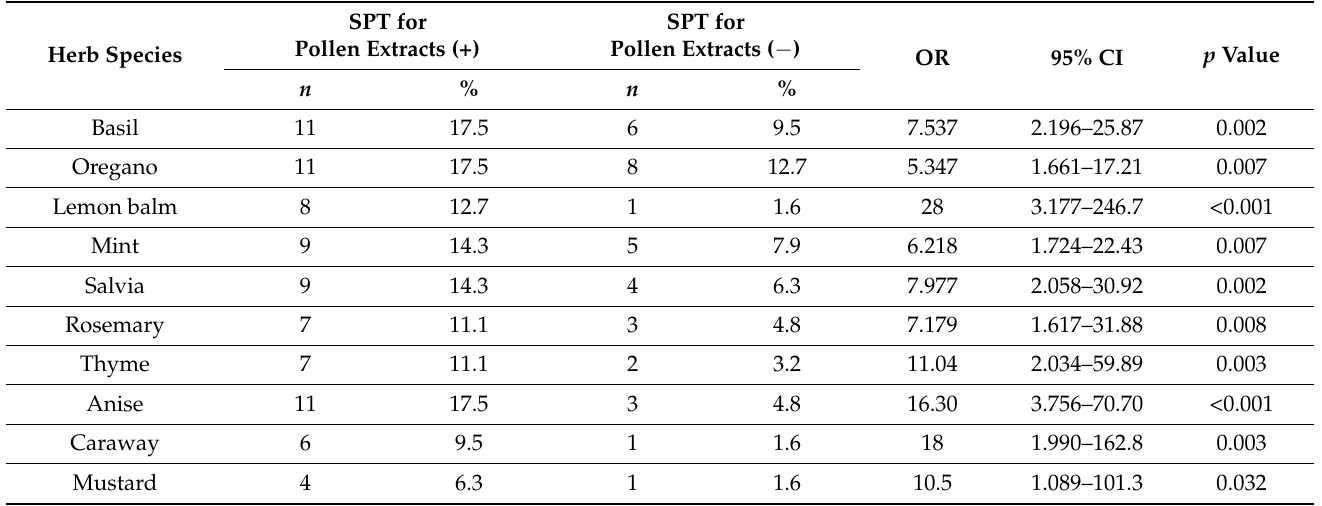
Table 2. Incidence and odds ratio (OR) of positive SPT ( Φ ≥ 3 mm) for particular herbs in relation to positive (+) or negative ( − ) SPT for pollen extracts in children.